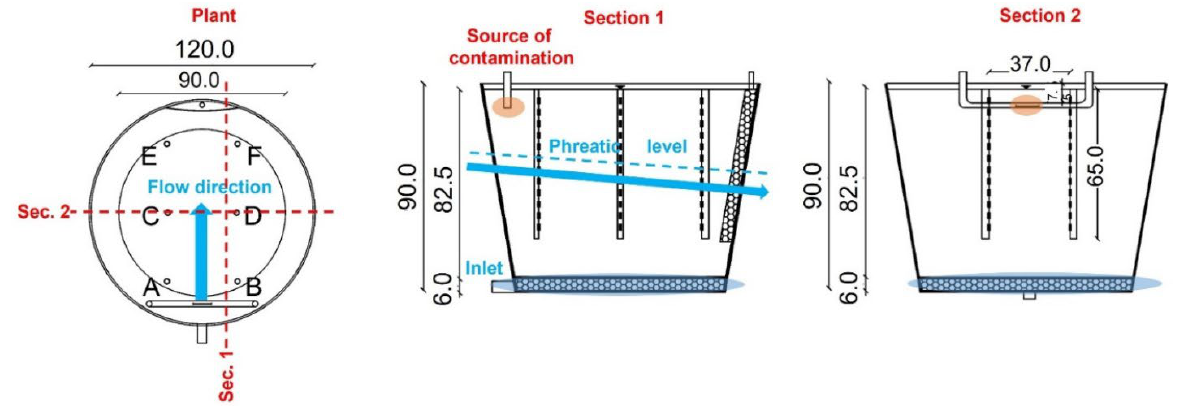
Figure 4. Laboratory experimental set-up. A–F are the piezometers instrumented for CH-ERT. Dis- tances are in cm. Modified from [65].